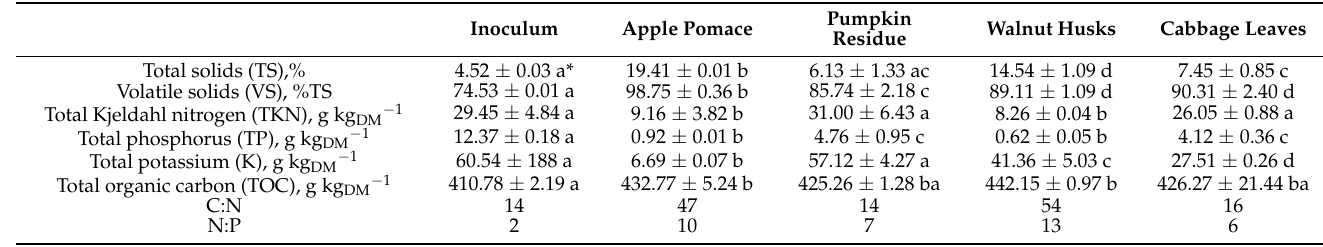
Table 1. Chemical composition of inoculum and residues.